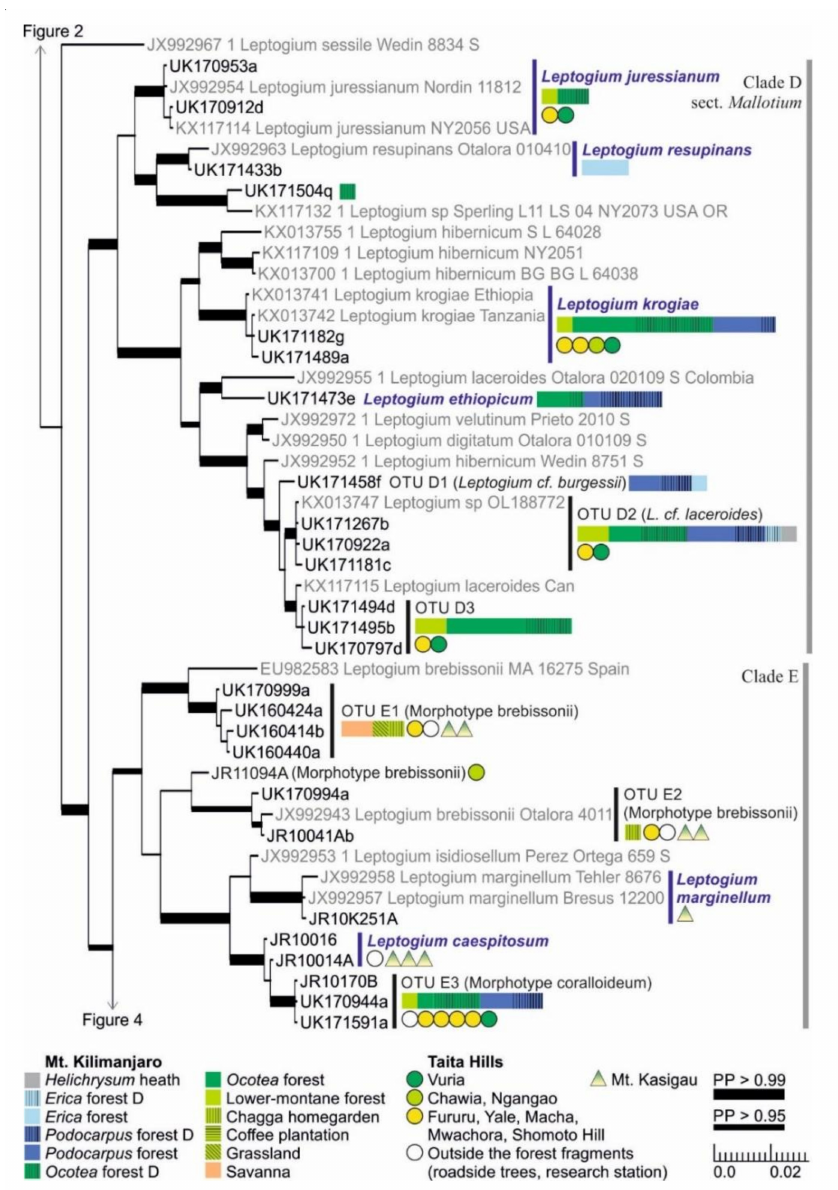
Figure 3. Clades D and E of the Bayesian tree of the genus Leptogium based on the mtSSU and 5.8S marker regions (Figure S2). Newly obtained sequences are in black, including one specimen representing each mtSSU variant; all specimens belonging to each clade are listed in Table S1. Established species are in blue. For more detailed explanation, for example, for the colors and shapes indicating the distribution and abundance of taxa, see the caption of Figure 2. D = disturbed; PP = posterior probability (for the precise values, see Figure